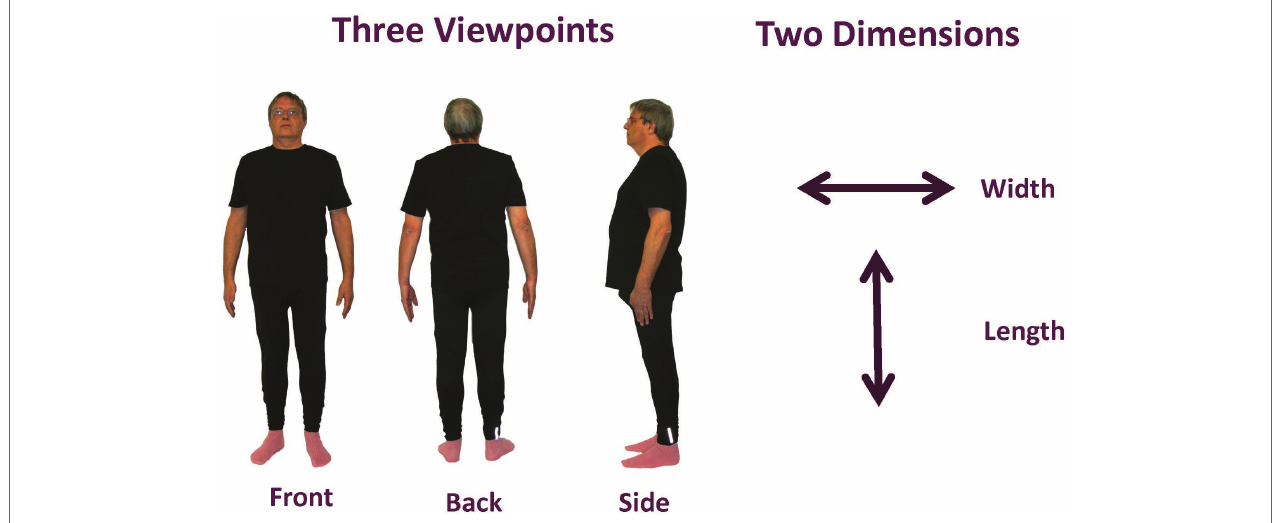
FIGURE 1 | Experimental design and conditions. Sample images of the full body are shown for each viewpoint: front, side, and back. Width and length dimensions (indicated on the right of the figure) were distorted separately for each of the three